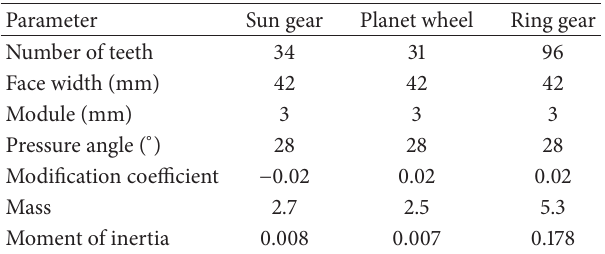
Table 1: The planetary gear transmission system